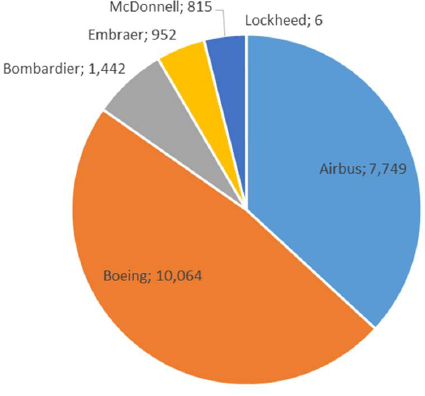
Figure 3. Worldwide manufacturer share of active aircraft (airliners).